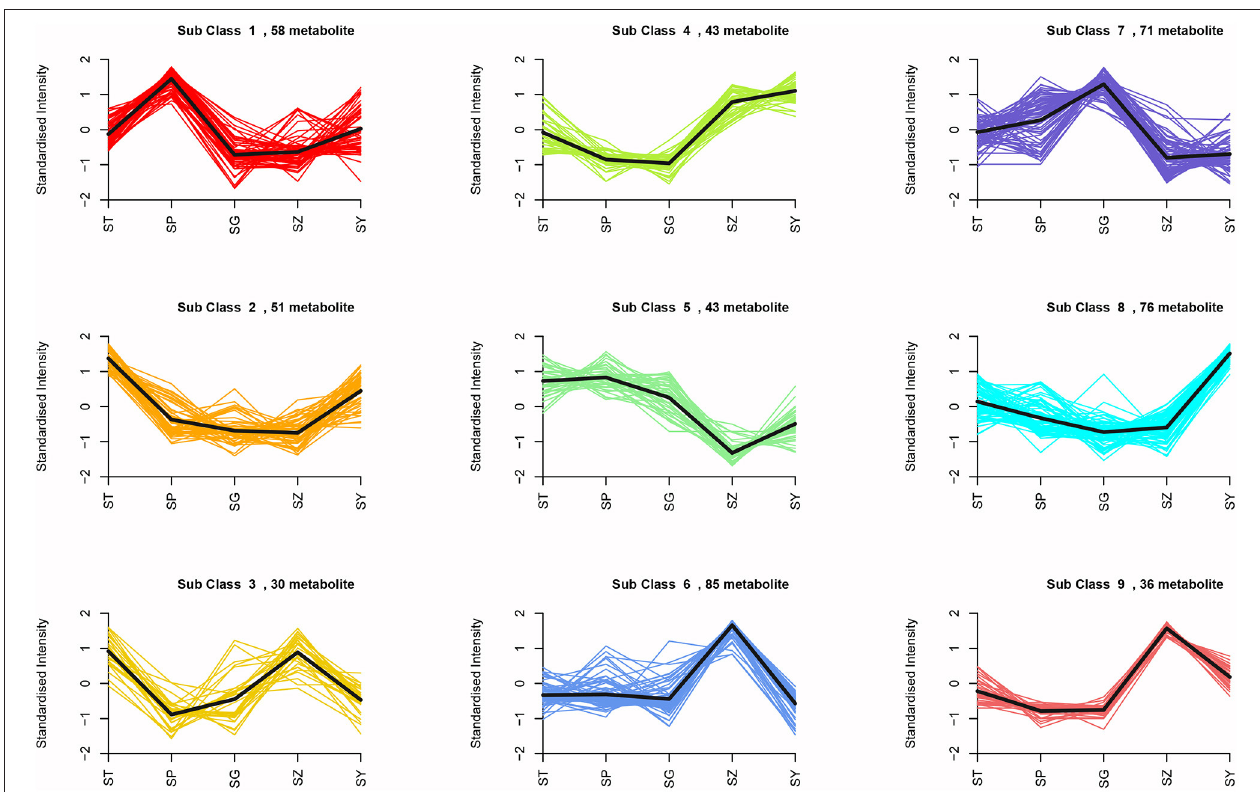
FIGURE 7 | K-means analysis of differential